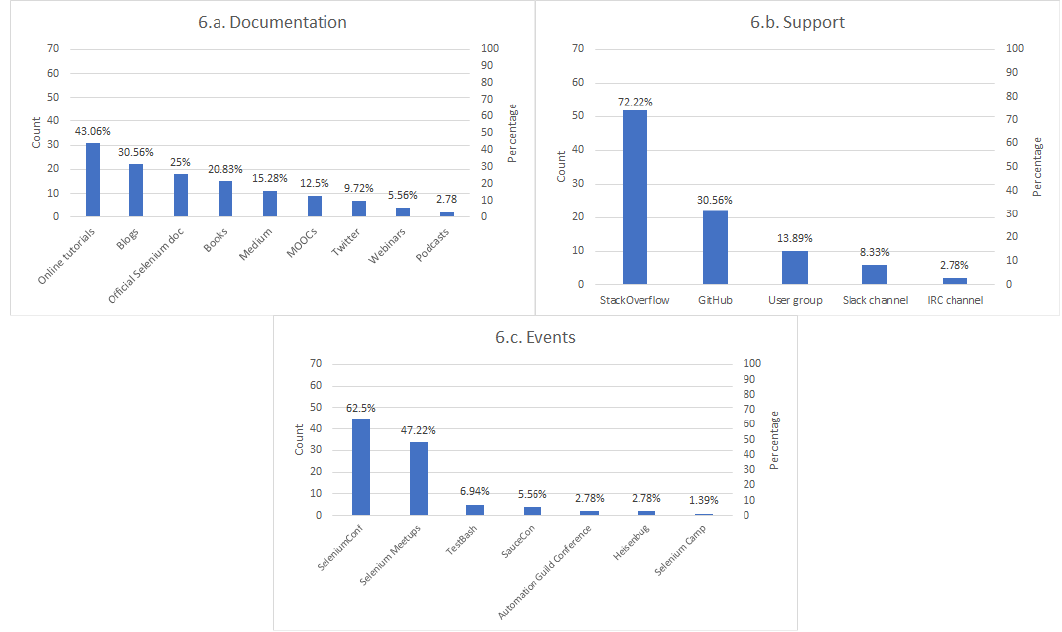
Figure 15. Sources of information for Selenium documentation, support, and